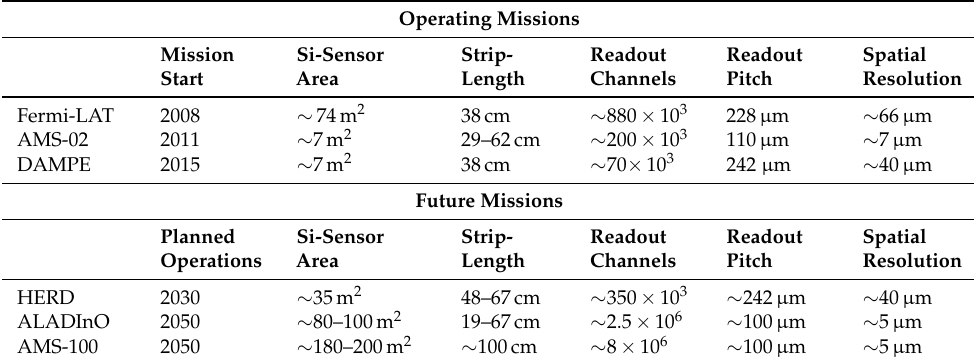
Table 1. Main parameters of operating and future Si-trackers in space [1,29,30,40–42]. In the table, the column “Strip-Length” provides the length or the range of lengths of SiMS “ladders” made of neighboring sensors connected in daisy-chain